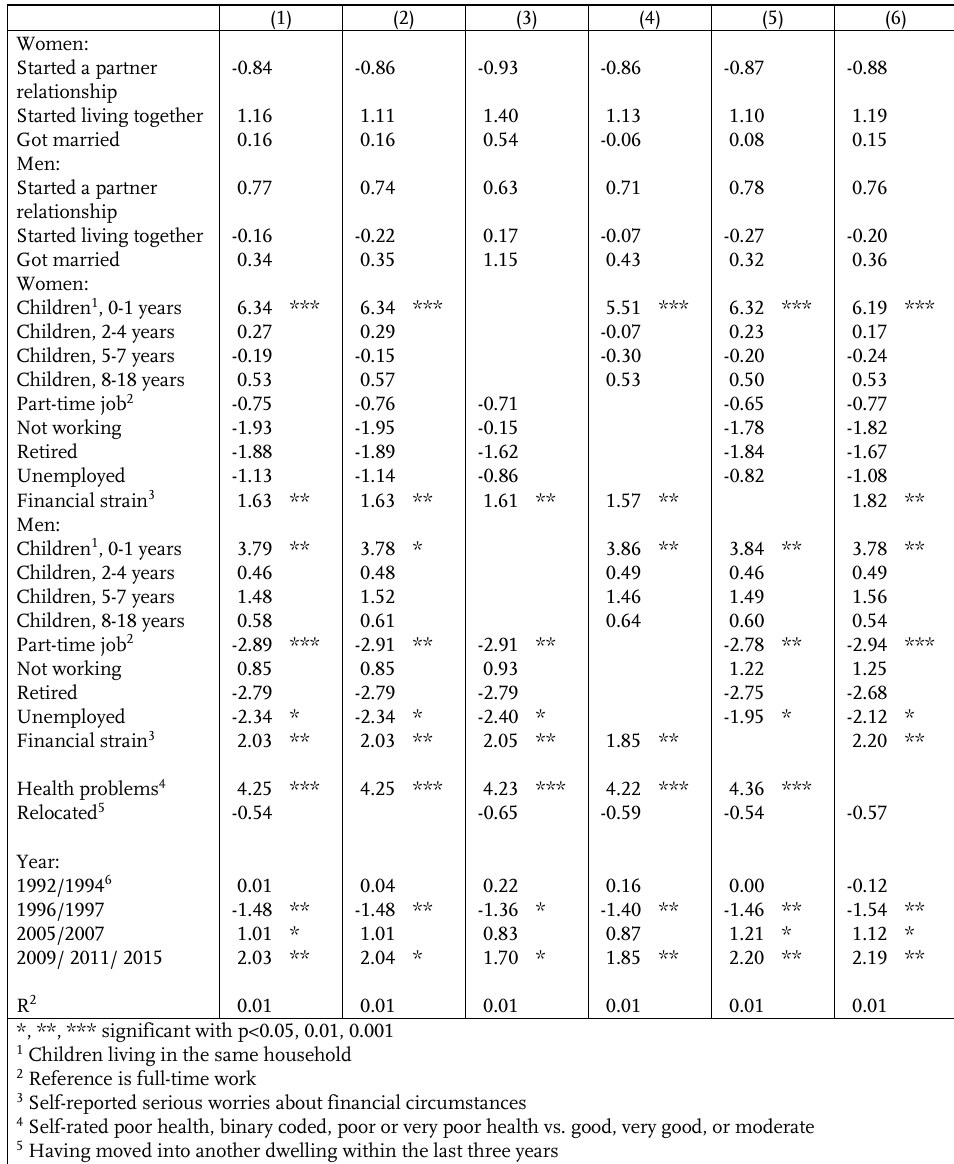
Table A.4 : Effects of partner relationships, children, employment, relocations, health and financial strain on absence of both secondary-sphere and tertiary-sphere contacts (linear-probability models with fixed effects, percentage